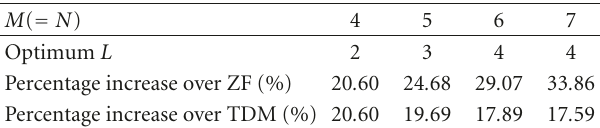
Table 1: Optimum L values and the percentage increase of the proposed scheme’s sum rate over ZF and TDM schemes for di ff erent numbers of